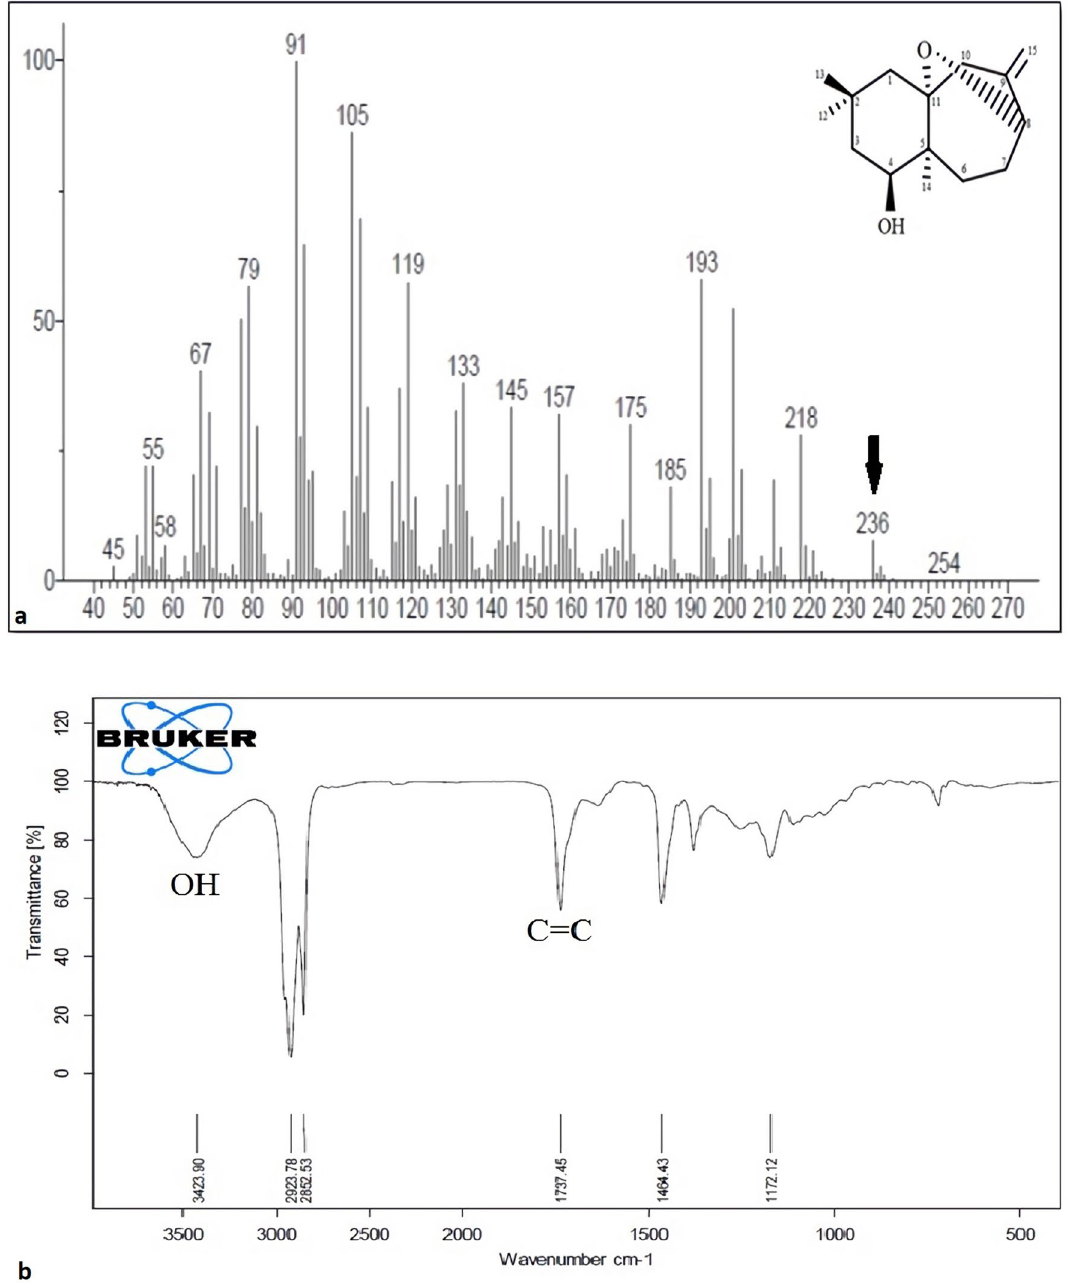
Figure 3. The ( a ) GC/MS and ( b ) FT-IR spectra of compound 1